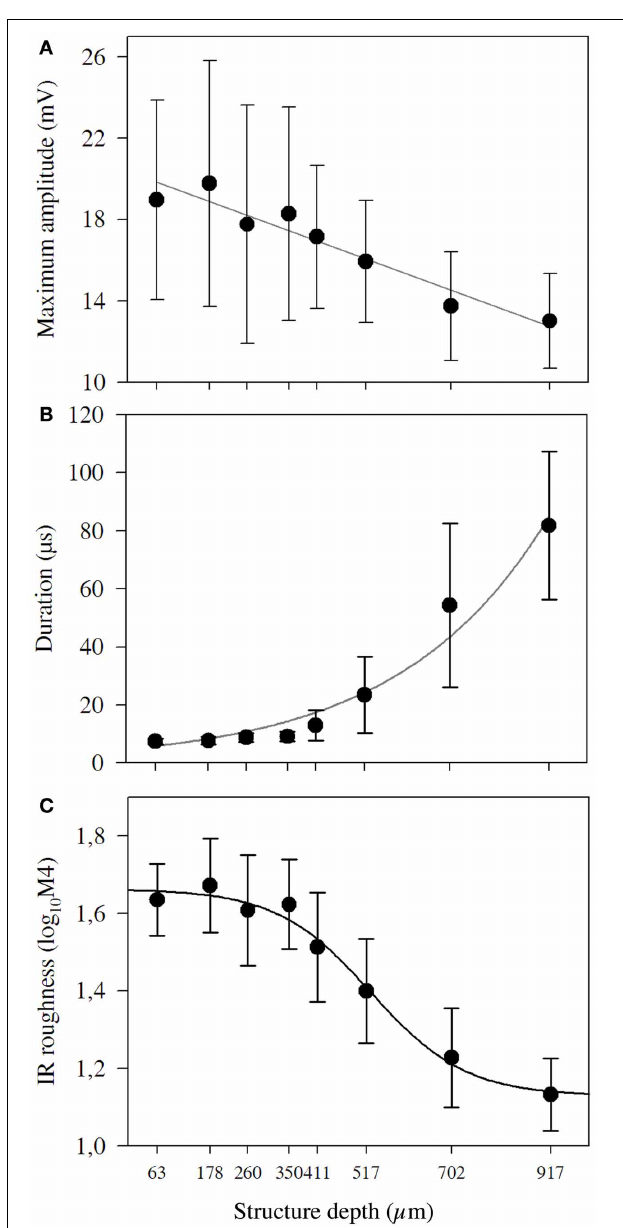
FIGURE 2 | Amplitude, duration and roughness of impulse responses of structured targets. For each target, we analyzed 51 impulse responses measured from different directions. (A) Mean maximum amplitude and standard deviation of the targets (cid:2) impulse response. The black line marks the linear regression ( y = 0 . 68 − 0 . 00028x; r 2 = 92 . 2; p < 0 . 001). (B) Mean duration and standard deviation of the targets (cid:2) duration. The black line marks the exponential growth regression ( y = 4 . 8e 0.003x; r 2 = 98 . 3; p < 0 . 01). (C) Mean IR roughness and standard deviation (log 10 M4) for targets with different structure depths. The black line marks the sigmoidal